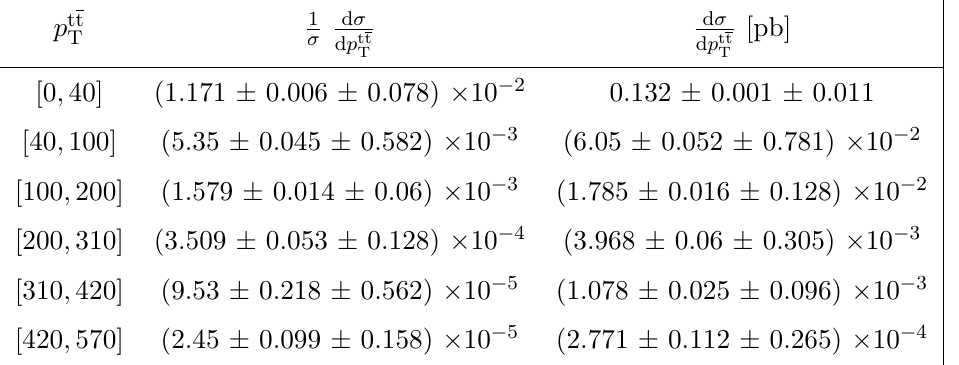
Table 24 . The measured di(cid:11)erential cross section and bin boundaries for each bin of the normalized and absolute measurements of the tt di(cid:11)erential cross section at particle level in the (cid:12)ducial phase space as a function of p tt are tabulated. T